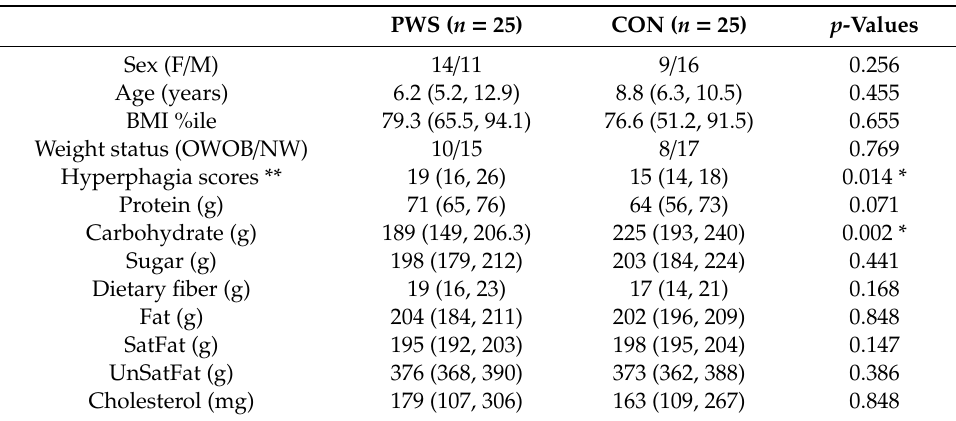
Table 1. Participant